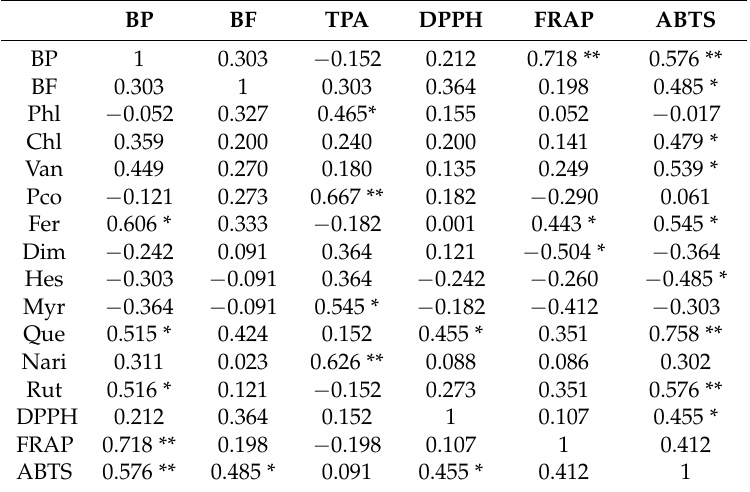
Table 6. Analysis of the correlation of the bound phenolic composition and content with the antioxidant activity. BP BF TPA DPPH FRAP ABTS